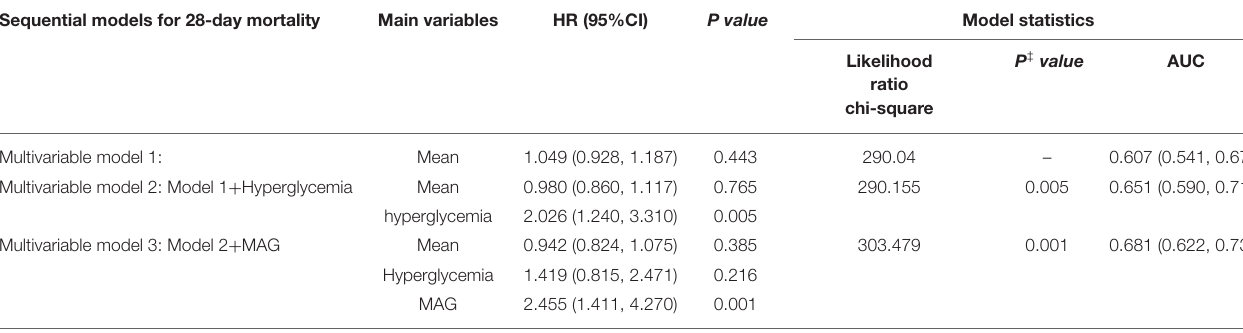
TABLE 5 | Multivariable COX regression: associations of hyperglycemia and MAG With 28-day mortality. Sequential models for 28-day mortality